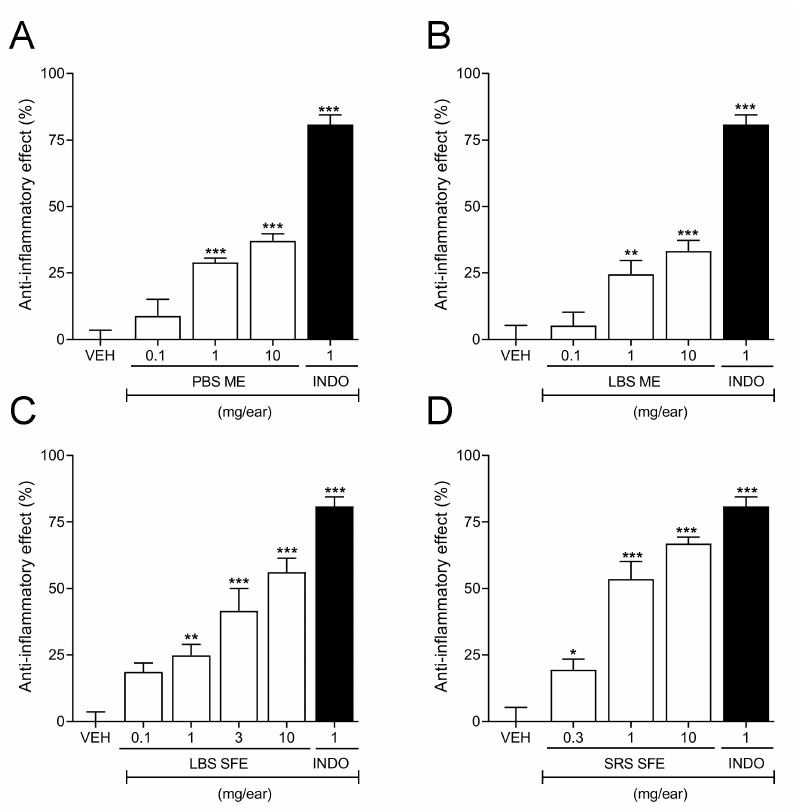
Figure 4. ( A – D ) Dose–response curves of the anti-inflammatory effect of the extracts of C. chinense by-product extracts obtained by ME and SFE as a function of the amount of extract mg/ear. Each bar represents the mean ± SEM (n = 6–8 ears per dose). * p < 0.05, ** p < 0.01, *** p < 0.001 different from the group treated with the vehicle (VEH), by one-way ANOVA followed by Dunnett’s test. INDO: